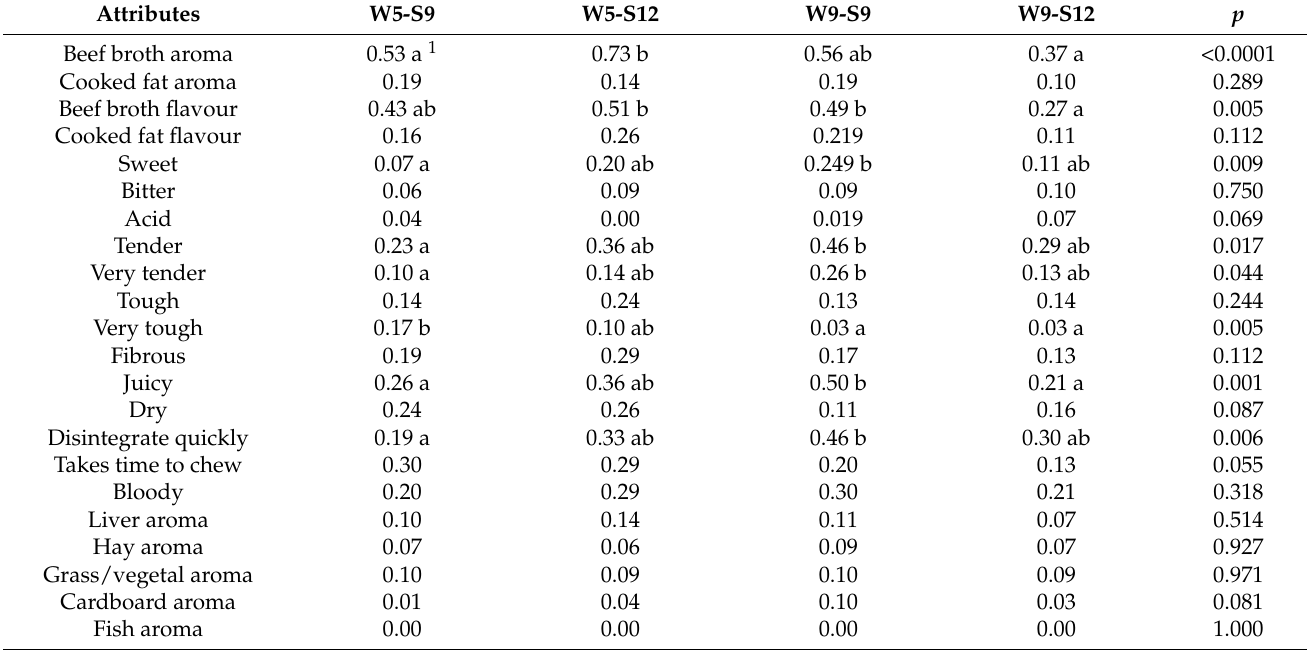
Table 2. The proportion of consumers identifying each